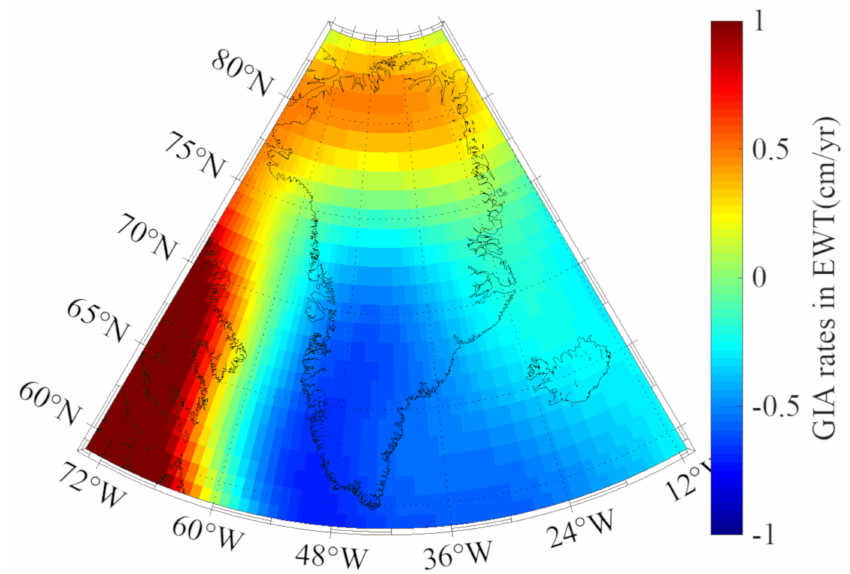
Figure 2. The Glacial Isostatic Adjustment rates in the GrIS according to the GIA model prepared by Geruo et al. (2013) (in terms of the equivalent water thickness, cm /